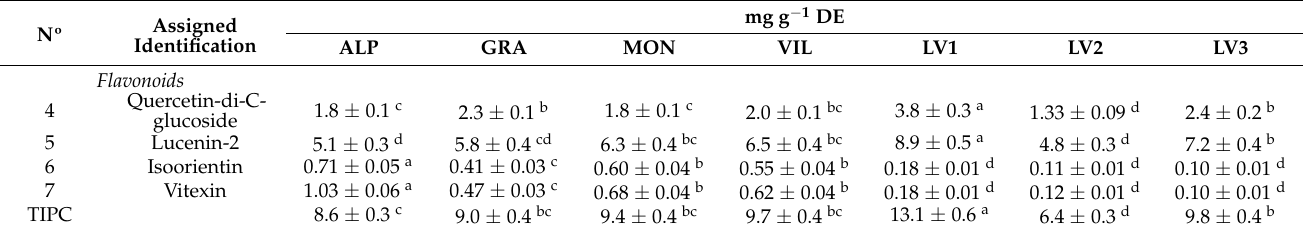
Table 3. Quantification of the main compounds detected in extracts of C. reverchonii in